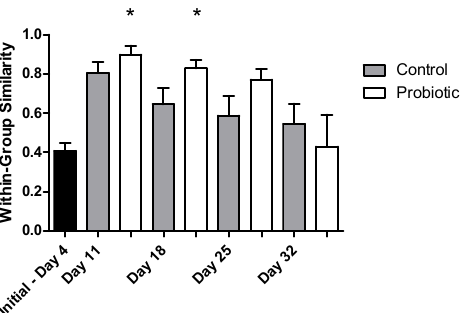
Figure 5. The similarity of the microbial profiles based on the Jaccard metric during seabass larvae development as indicated by DGGE analysis (values closer to 1 indicate a higher similarity between microbial profiles) between the control (grey) and the probiotic (white) treatment. A nonparametric t- test was performed, showing a significant effect ( p < 0.05) of probiotic administration in the microbial community profiles between days 11 and 18 with the initial day (4 days after hatching (DAH); stars).